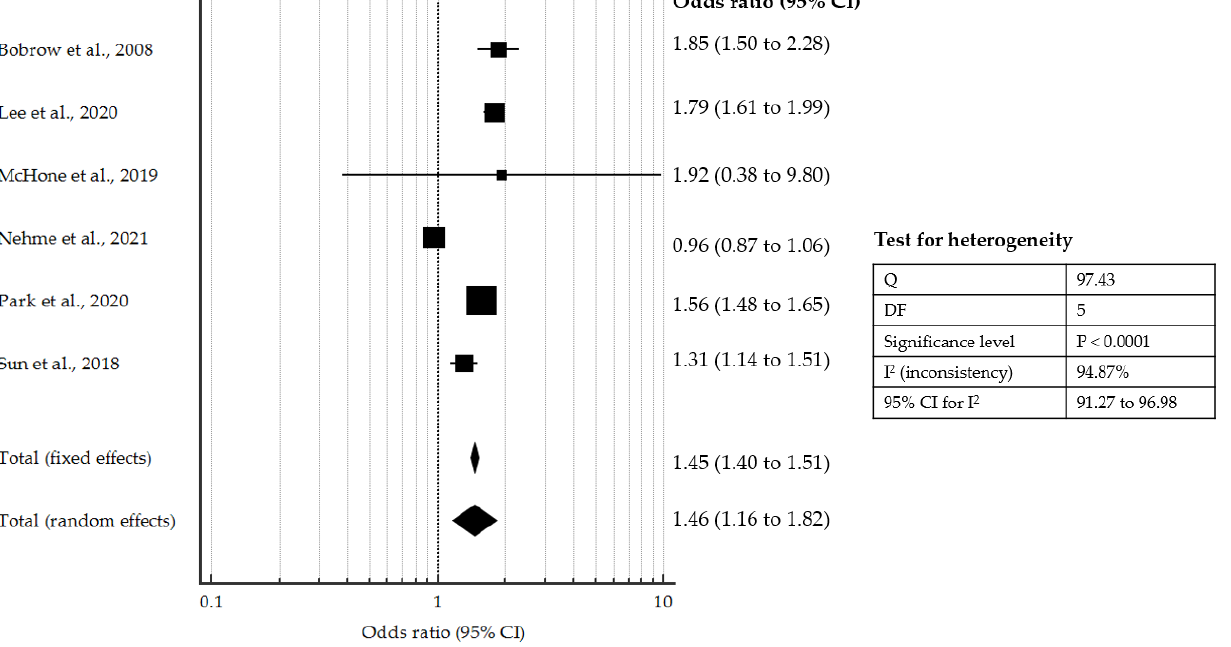
Figure 3. Forest plot showing pooled OR for any ROSC with HP CPR or similar intervention compared to controls.